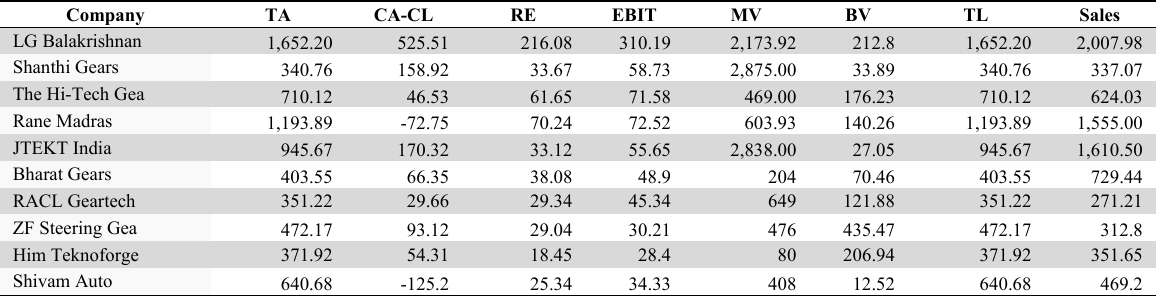
Financial information of Indian Auto ancillary gear manufacturing